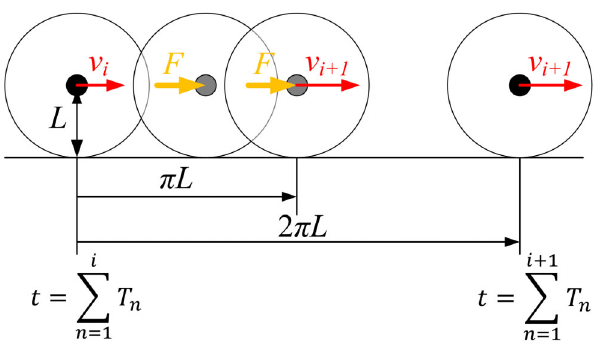
i are the radius of the disk, the stochastic force with zero mean applied to the center of mass while the disk is rolling from 0 to p radian, the velocity of the disk at the end of i th cycle, duration of i th cycle, respectively. The velocity v i + 1 is determined right after the disk rolls by p radian because the stochastic force is no longer applied to the disk hence momentum is